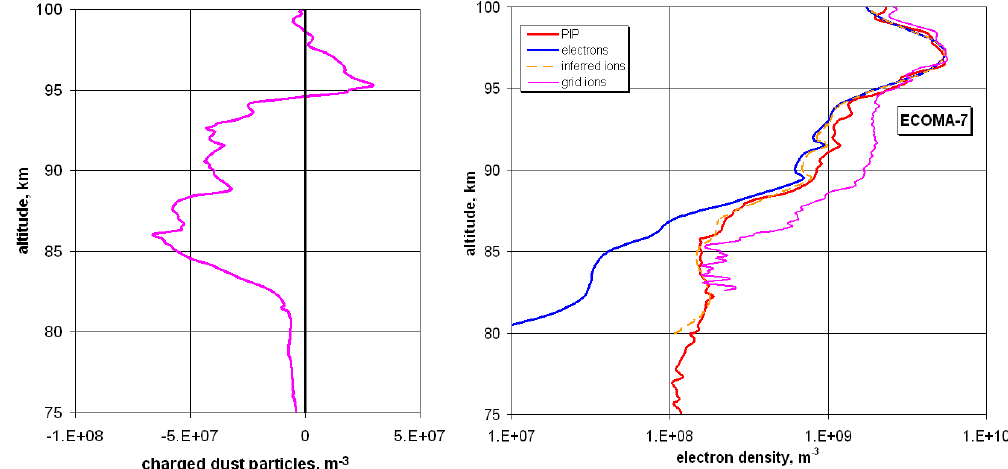
Figure 5 Naturally charged dust collected by the ECOMA instrument in flight 7 (left panel). The negative sign indicates that the particles were negatively charged, the positive current seen in the ECOMA dust data above 95 km is not an indication of positively charged dust, but rather a sign of incomplete shielding against positive ions (Rapp et al., 2011). Electron and ion densities measured in the same flight (right panel); the inferred ions (dashed line) are obtained from the measured electron densities applying Eq. (1).